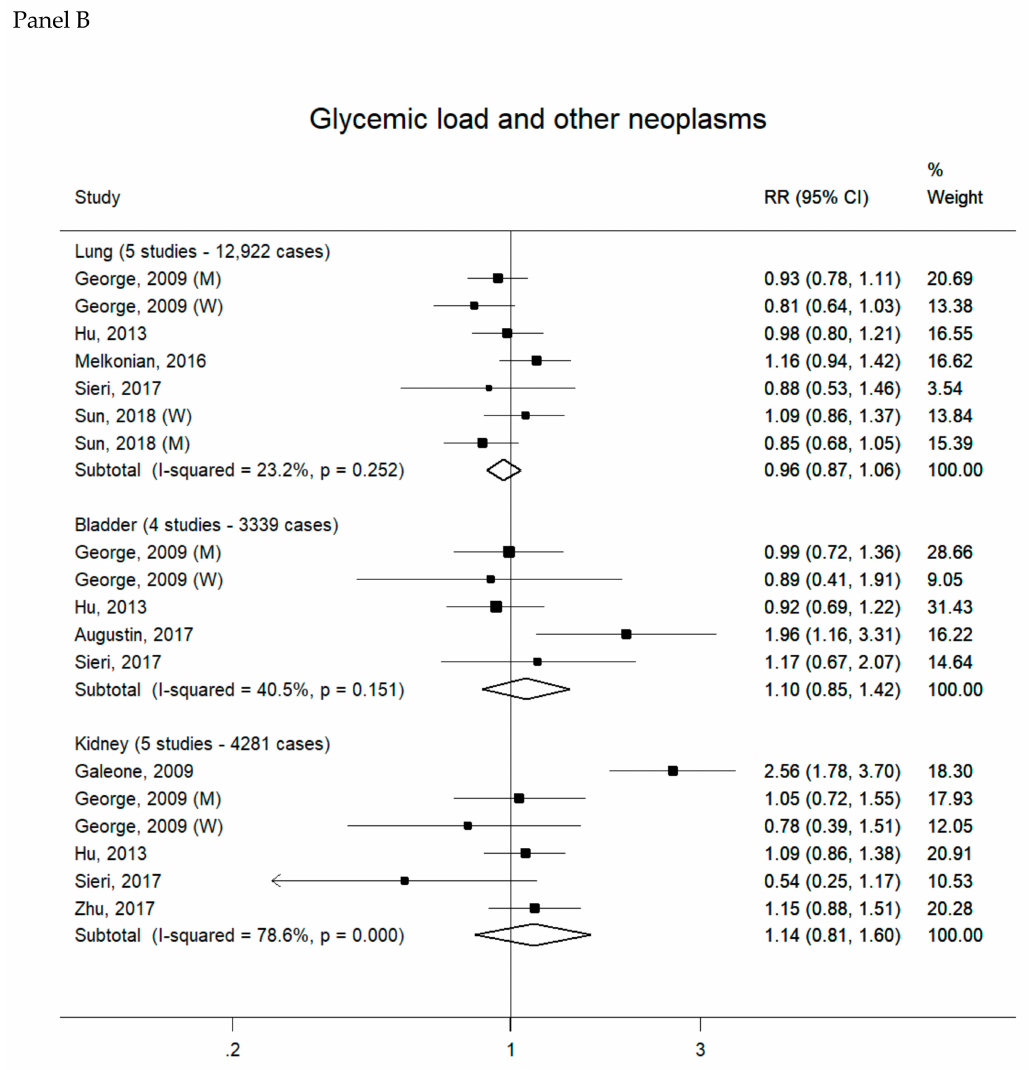
Figure 3. Study-specific and summary relative risks (RRs) of other neoplasms for the highest versus the lowest category of glycemic index (Panel A) or glycemic load intake (Panel